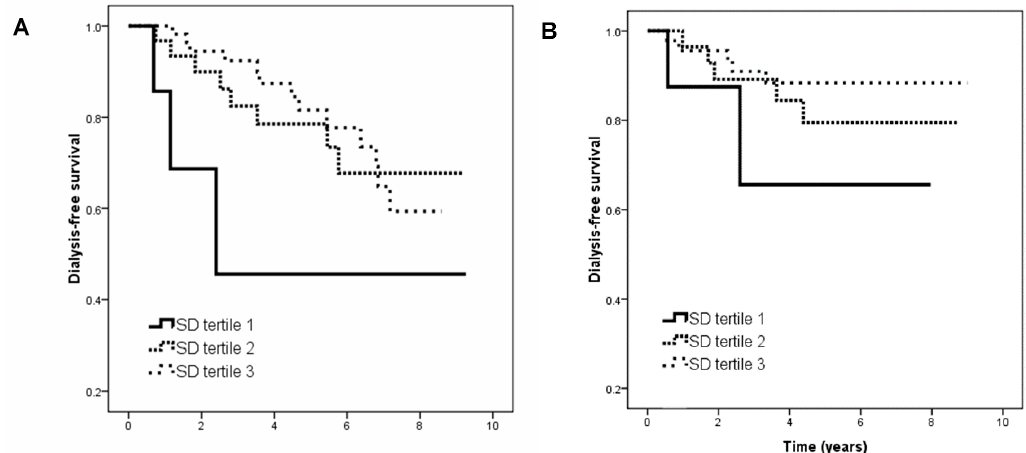
Figure 4. Kaplan–Meier analysis of dialysis-free survival according to tertiles of HbA 1C SD among